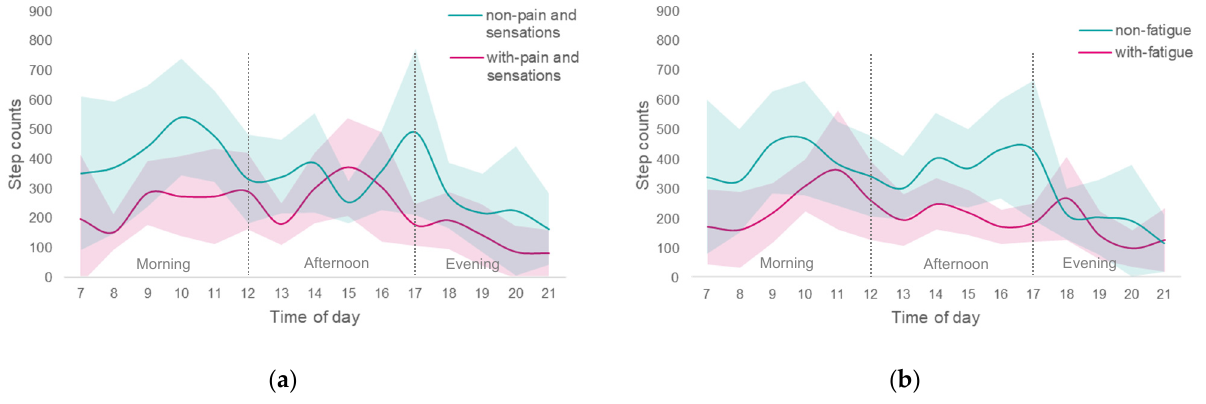
Figure 1. Comparison of step counts taken at different times of day with and without NMS; Red indicates patients with NMS, and green indicates patients without NMS. The solid line is the mean step count per time of day, and the surrounding light-colored zone is the 95% CI; ( a ) with and without pain and sensation; ( b ) with and without fatigue. There was no interaction by time of day for the pain and other sensations ( p = 0.20, effect size by partial η 2 (ES) = 0.36), and fatigue ( p = 0.08, ES = 0.38) patient groups, respectively.